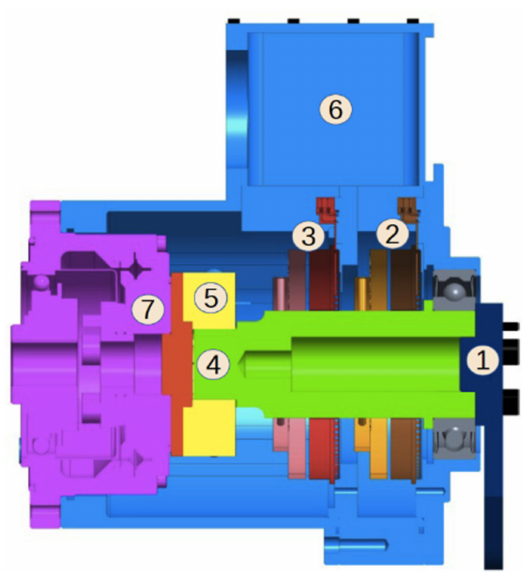
Figure 12. Output parts of the actuator.